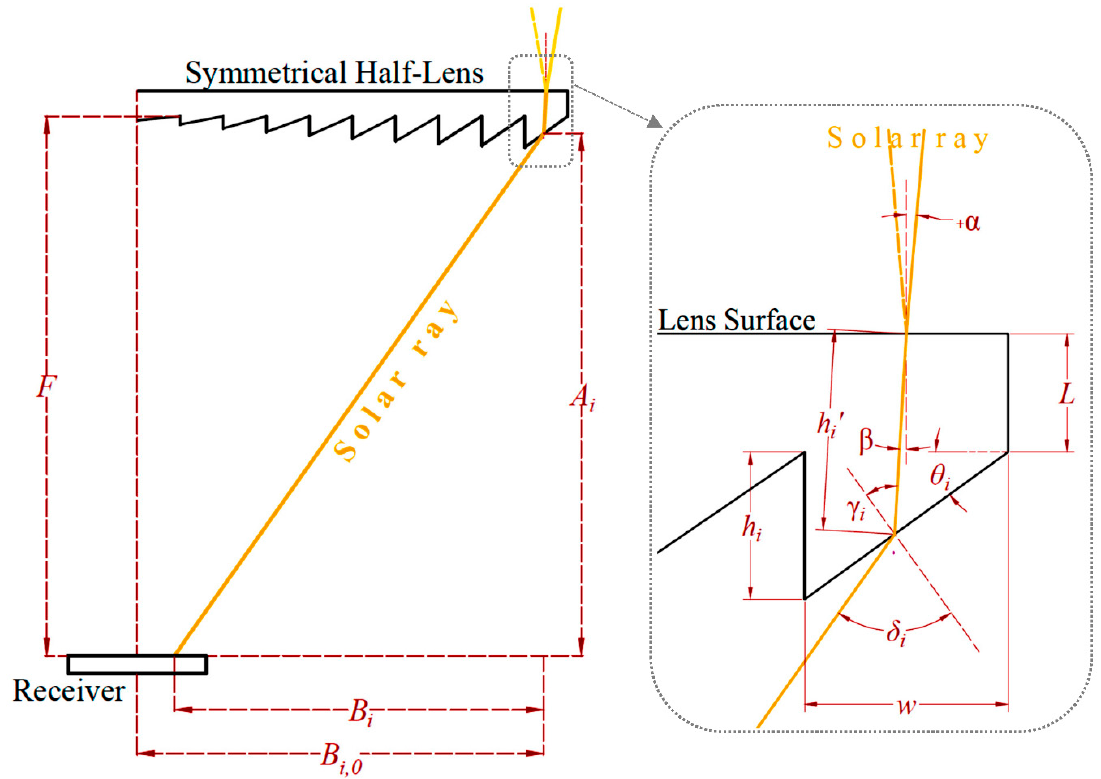
Figure 1. Schematic of the refraction geometry for the primary optical element (POE) design. (Half-lens shown is not to scale).